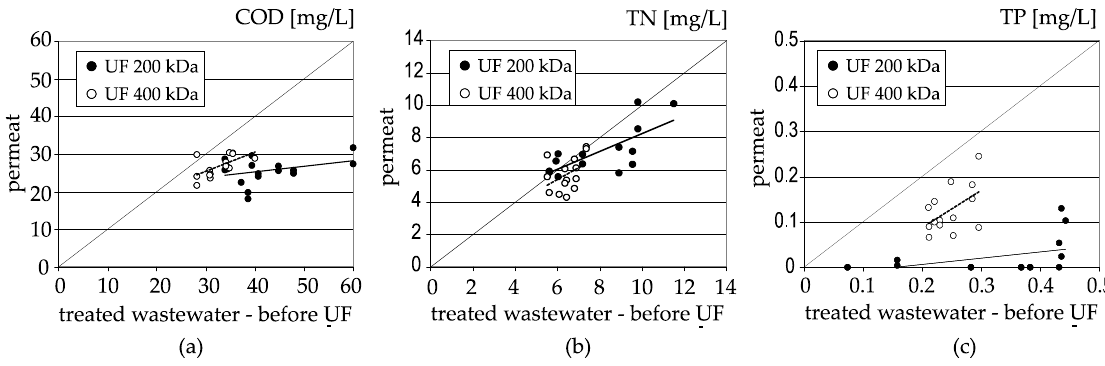
Figure 2. Concentrations of selected physico-chemical parameters: ( a )—chemical oxygen demand—COD; ( b )—total nitrogen—TN; ( c )—total phosphorus–TP, in the permeate after ultrafiltration in relation to their concentration in treated sewage supplied to the filtration system.